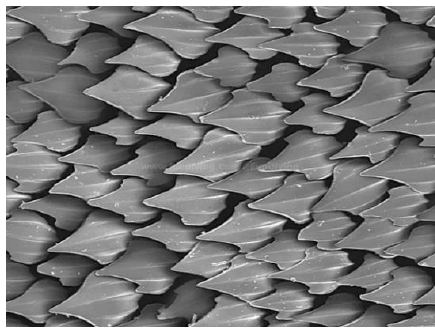
Figure 1. Shark placoid scale structure.